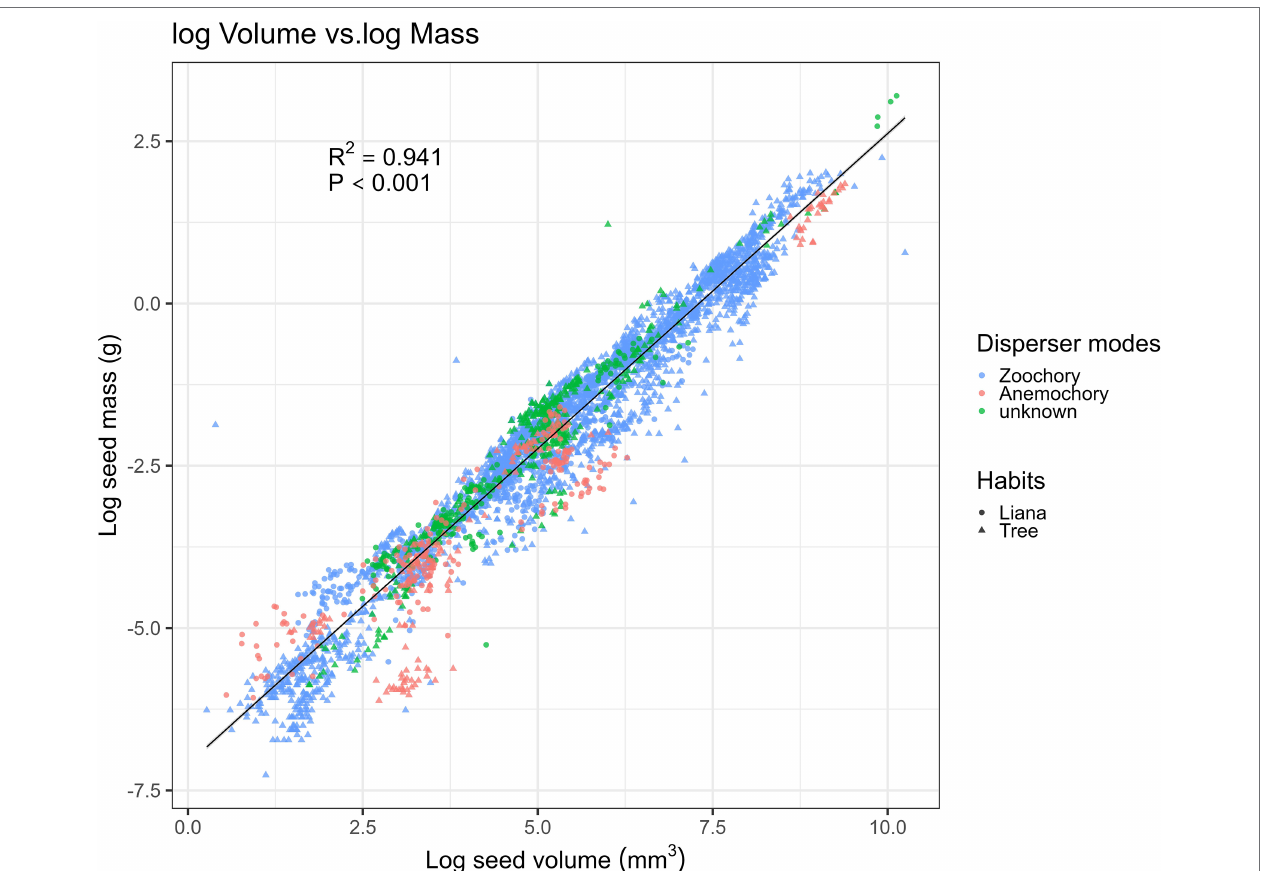
FIGURE 3 | Relationship between seed mass and volume-related traits with the predicted line (black solid line) fitted by the linear regression model ( N = 5,219). Samples are categorized into zoochory (blue), anemochory (red), and unknown (green), and tree and liana species are categorized by triangular and circular